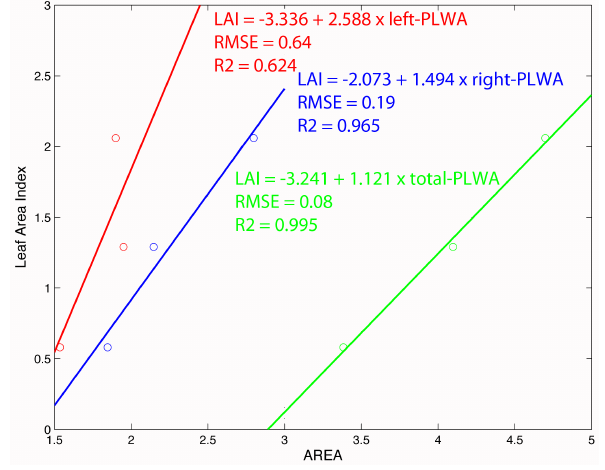
Figure 22. Linear regression between LAI and